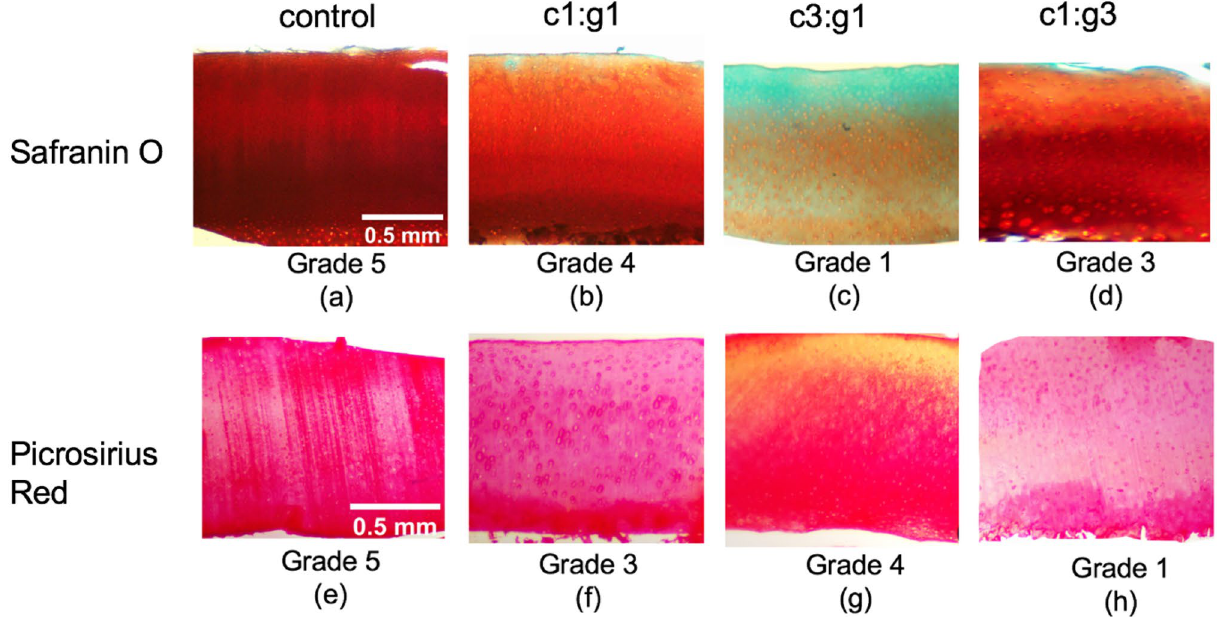
Figure 4. Change in intensity and consistency of the histochemical staining due to enzymatic activity compared to controls ( a , e ) in representative samples degraded with MMP-1 and MMP-9 of concentration c1:g1 ( b , f ), c3:g1 ( c , g ), and c1:g3 ( d , h ). Staining was performed with Safranin O to visualize PGs ( a – d ) and Picrosirius Red to visualize collagen ( e – h ). Classified as minimal (0), very weak (1), weak (2), moderate (3), strong (4), and very strong (5), scoring grade for each section is included for comparative analysis below the respective